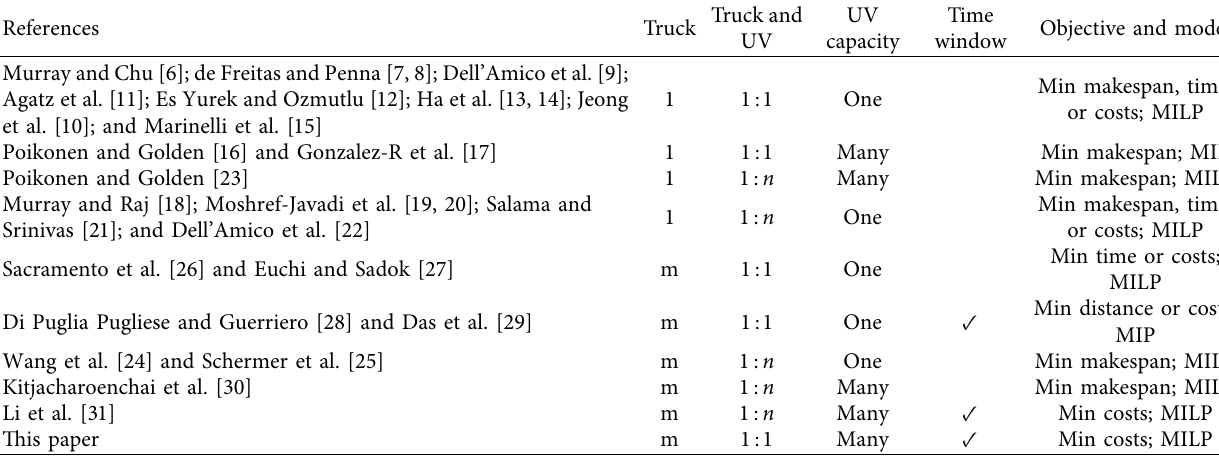
Table 1: Studies that are related to intersatellite